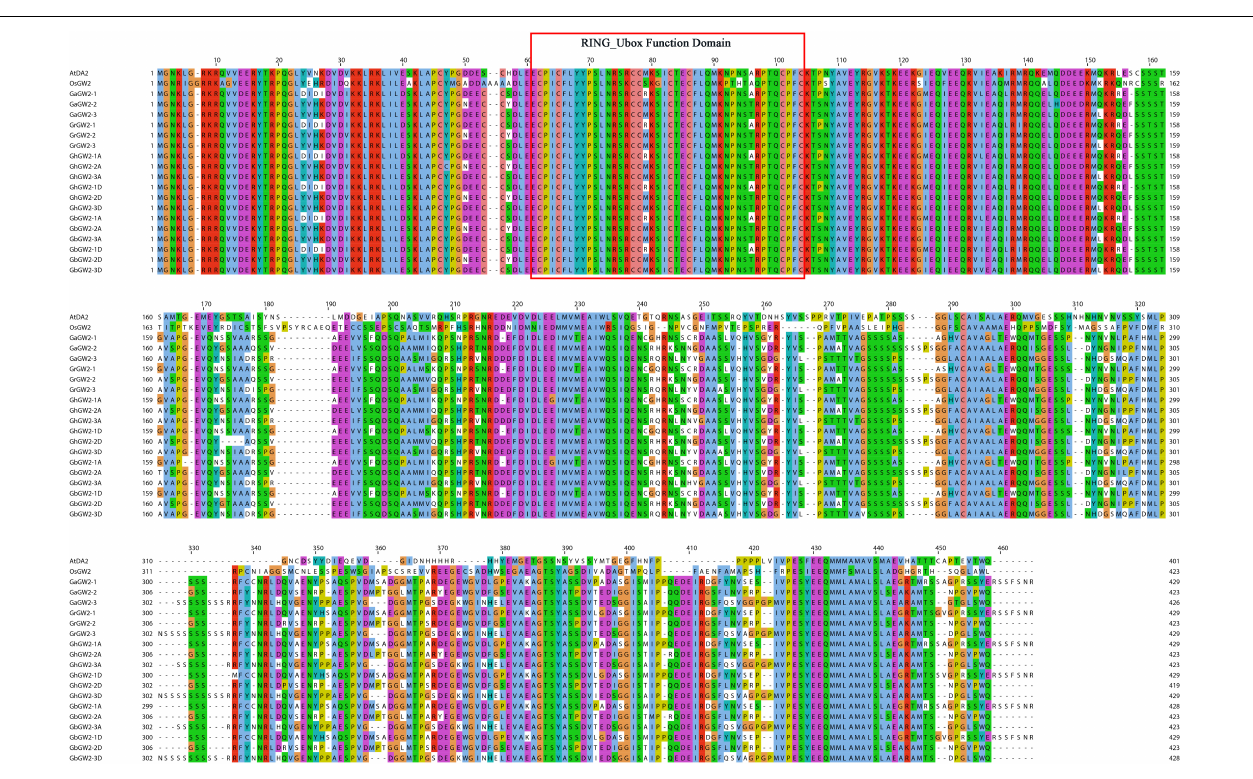
FIGURE 4 | Multiple sequence alignments of GW2-like amino acid